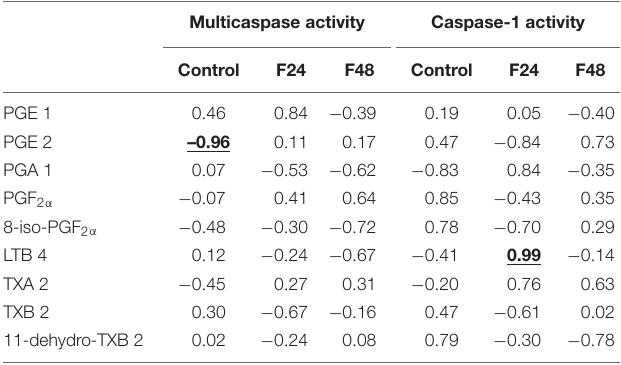
TABLE 1 | Pearson’s correlation coefficients ( r ) between the concentration of selected eicosanoids and multicaspase activity or caspase-1 activity. Multicaspase activity Caspase-1